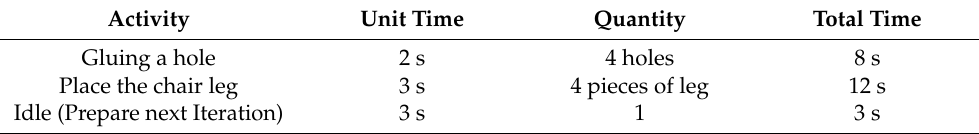
Table 9. MTM-UAS